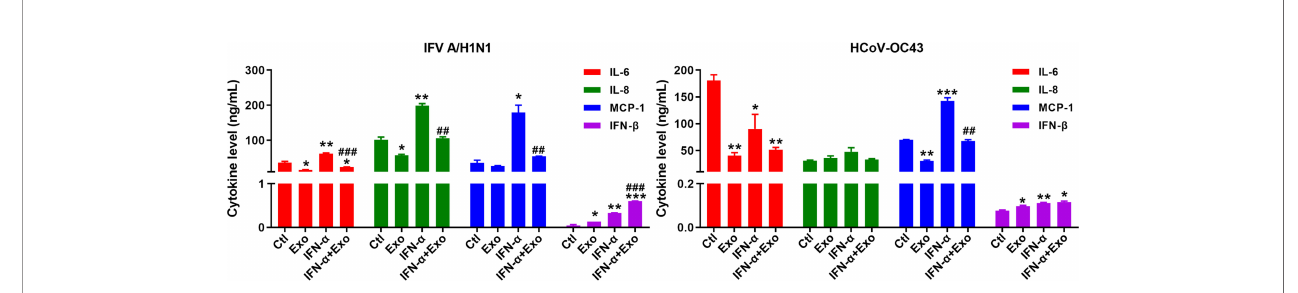
FIGURE 7 | Anti-in fl ammatory effect of U-exo during respiratory virus infection of ALI culture. Apical side of fully differentiated primary ALI culture was inoculated with IFV A/H1N1, or HCoV-OC43 viruses along with either media control (Ctl) or U-exo (Exo), IFN- a (10 ng/mL), or IFN- a combined with U-exo (IFN- a +Exo) for 90 min. Media was removed from the apical side, and media containing U-exo and/or IFN-; a was added to the basolateral side. 6 days later, supernatants from the basolateral side were collected and ELISA assay was performed to measure the secretion levels of pro-in fl ammatory (IL-6, IL-8, and MCP-1) and antiviral (IFN- b ) cytokines and chemokines. Data are shown as the mean ± standard deviation (SD) of the means from two independent experiments. Statistical analysis: *p < 0.05; **p < 0.01; ***p < 0.001, versus Ctl-treated cells. ## p < 0.01; ### p < 0.001, versus IFN- a -treated